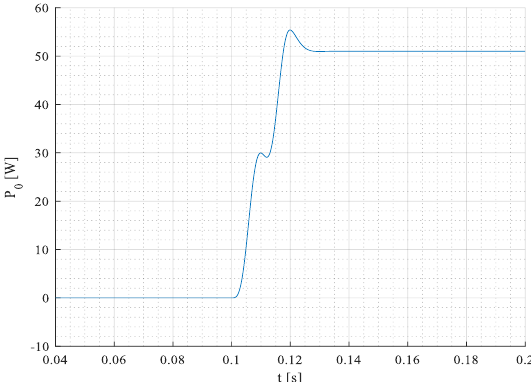
Figure 30. The waveform of zero power component Po.